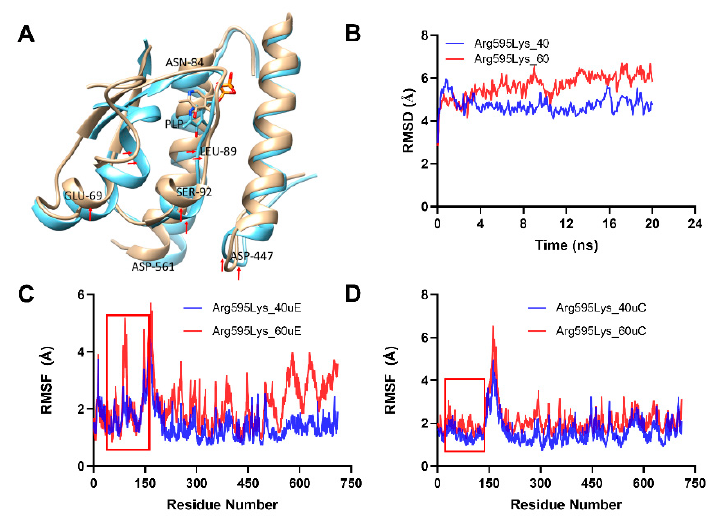
Figure 8. Analysis of thermal-induced structural alterations for the Arg595Lys. ( A ). This showed the structural variations for the aligned dimer unit involved interactions for the Arg595Ly variant at 40 °C and 60 °C, respectively. ( B ). RMSD for the backbone at 40 °C and 60 °C for the. Arg595Ly variant ( C , D ). This showed the RMSF of the two interacting Arg595Ly variant units ( C , D ) at 40 °C and 60 °C, respectively.